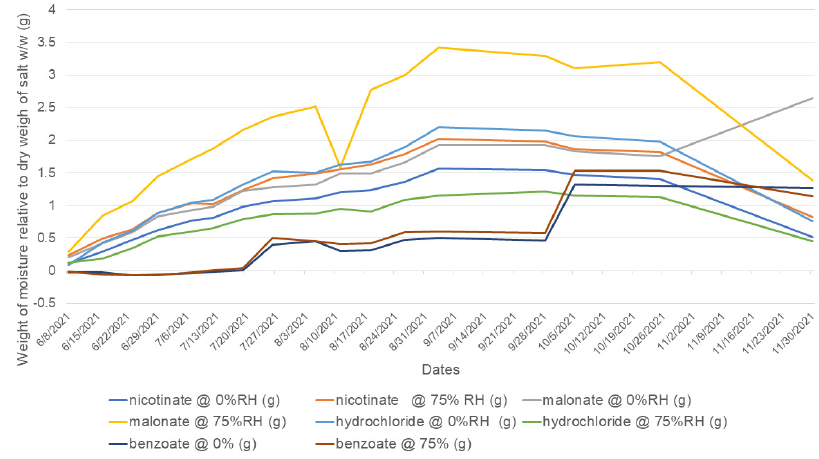
Figure 9. Vapor sorption and desorption trends observed for bedaquiline salts exposed to 0% RH and 75% RH. After 150 days of exposure, malonate and hydrochloride salts gained or lost more moisture than the other bedaquiline salts investigated.